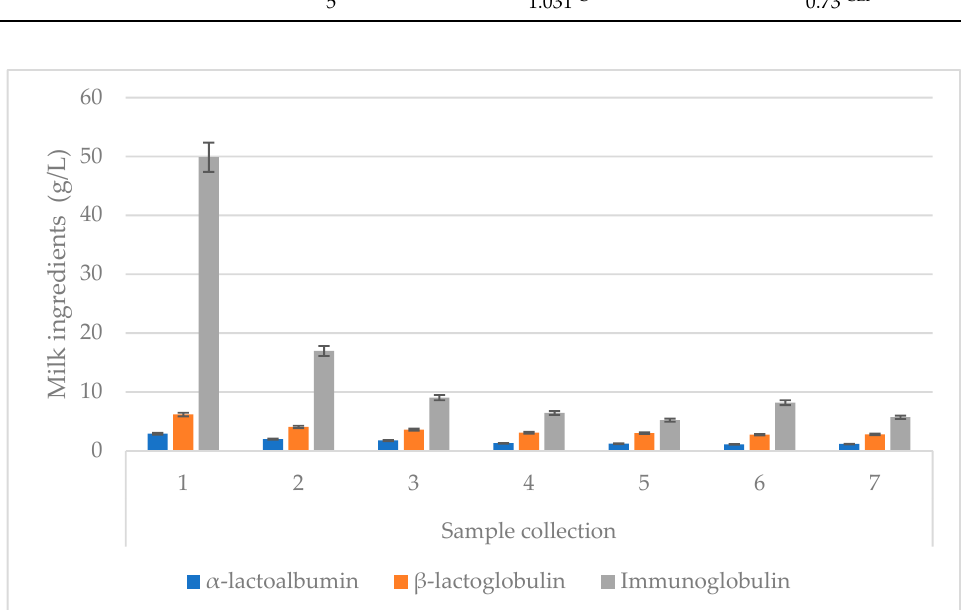
Figure 4. Changes in the whey protein values of colostrum for subsequent colostrum samples. Data are presented as least squares means along with their standard errors of mean. Statistical differences between collection groups at p ≤ 0.01.